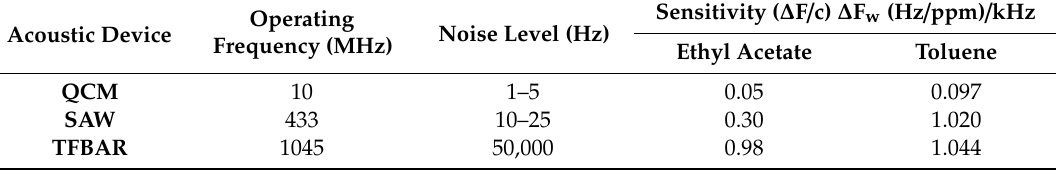
Table 4. Comparison of operating frequencies, noise level and sensitivities of QCM, SAW and thin film bulk acoustic resonator (TFBAR) devices for chemical sensing of ethyl acetate and toluene vapors. All the devices were coated with 75 (wt.%) SWCNT-based nanocomposite Langmuir–Blodgett layers, adapted with permission from